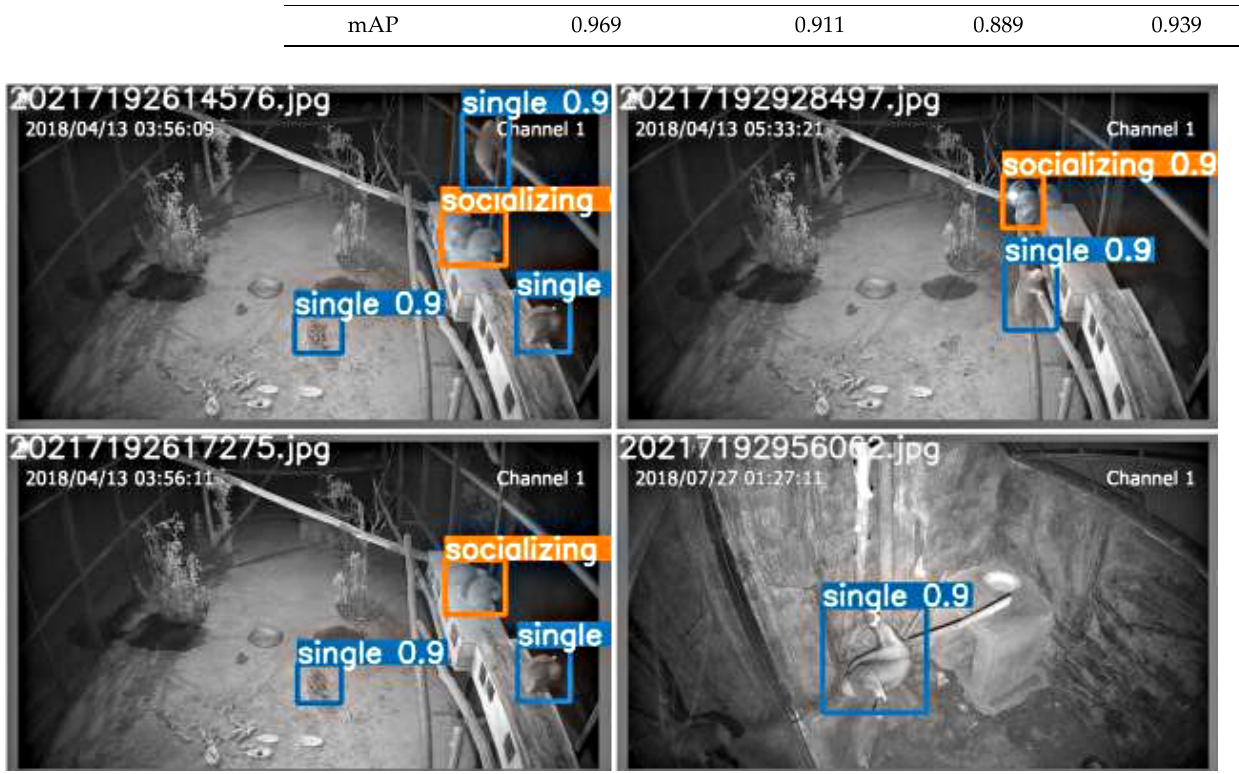
Figure 8. Detection effect of YOLOv5-CBAM + TC.